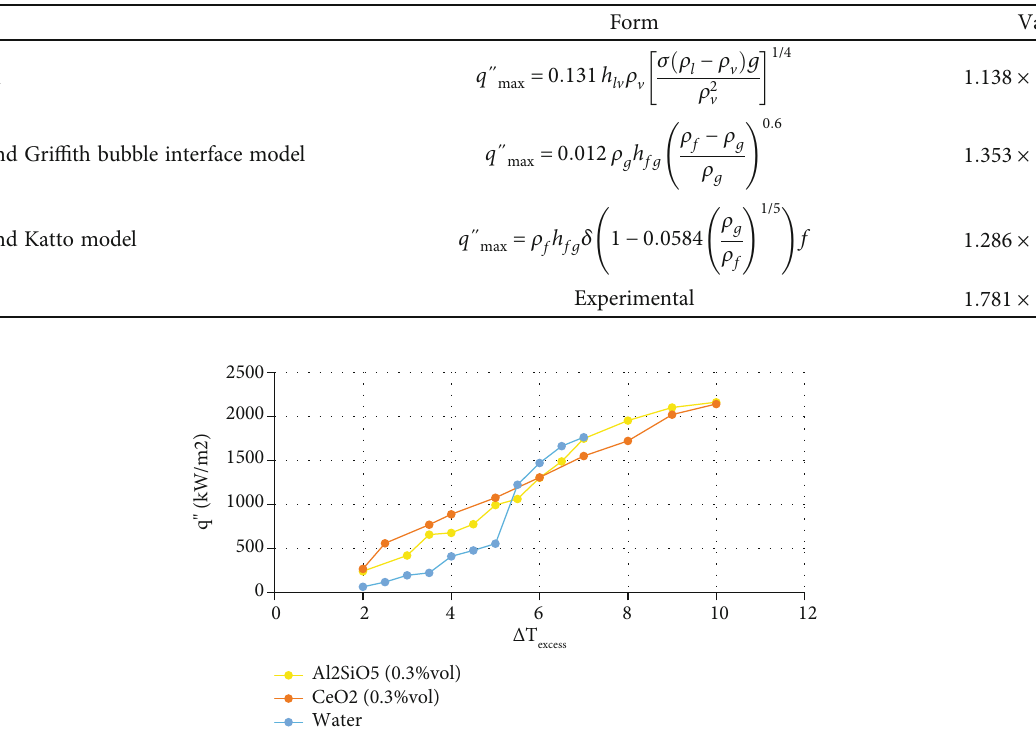
Table 2: Heat fl ux comparison to acclaimed studies.